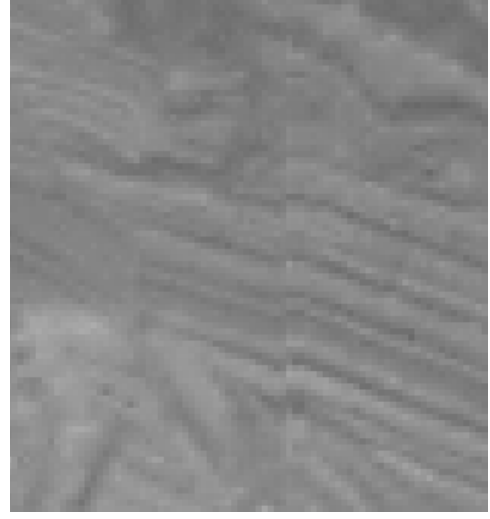
Figure 3. Mosaic error between the left and middle CCD image